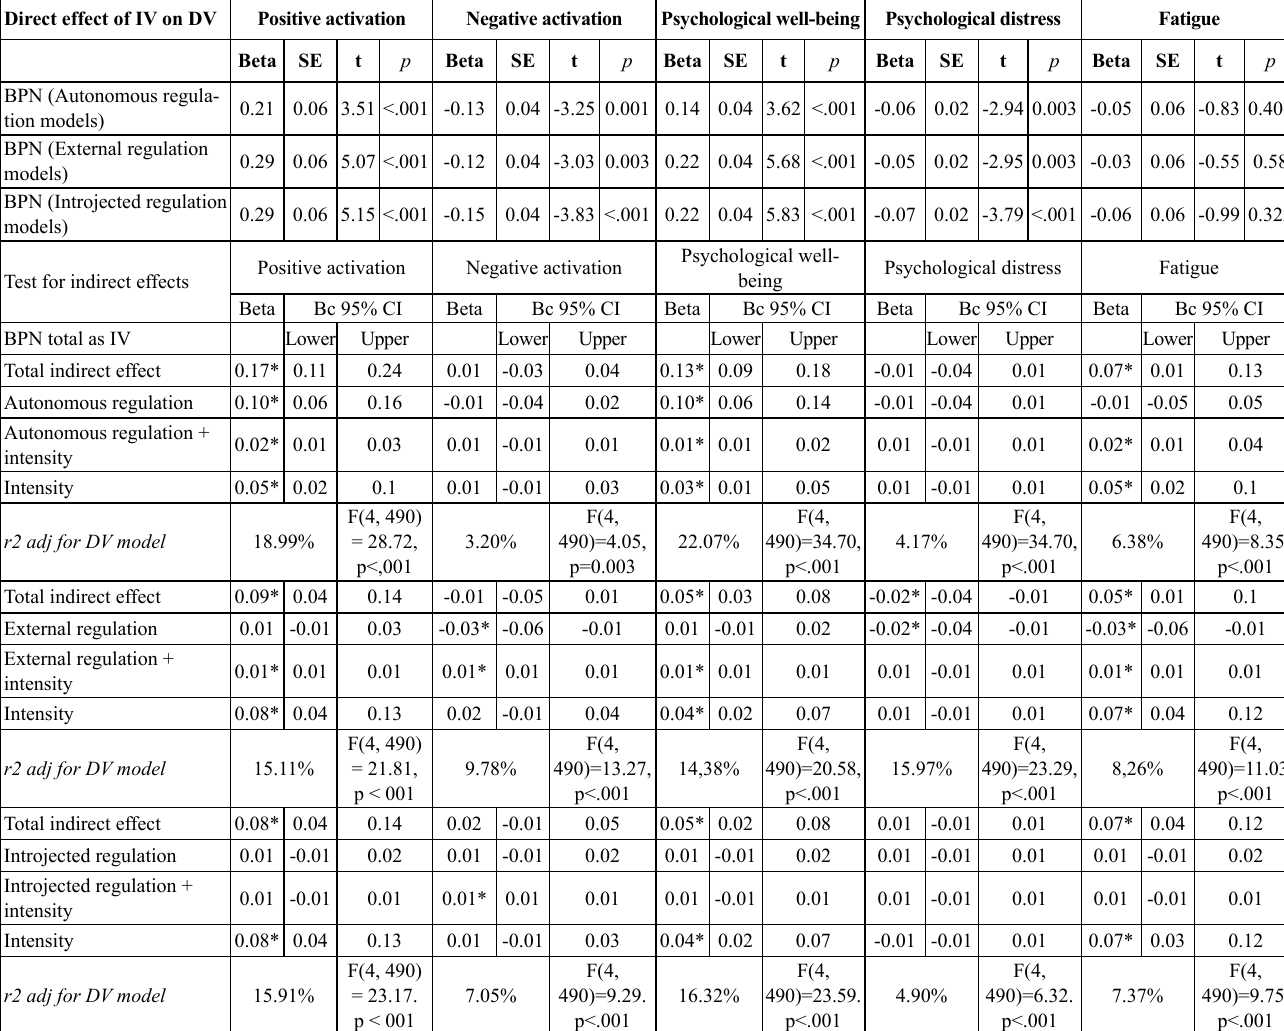
Table 2. Mediation analysis of basic psychological needs, motivational regulations, exercise intensity and emotional response Direct effect of IV on DV